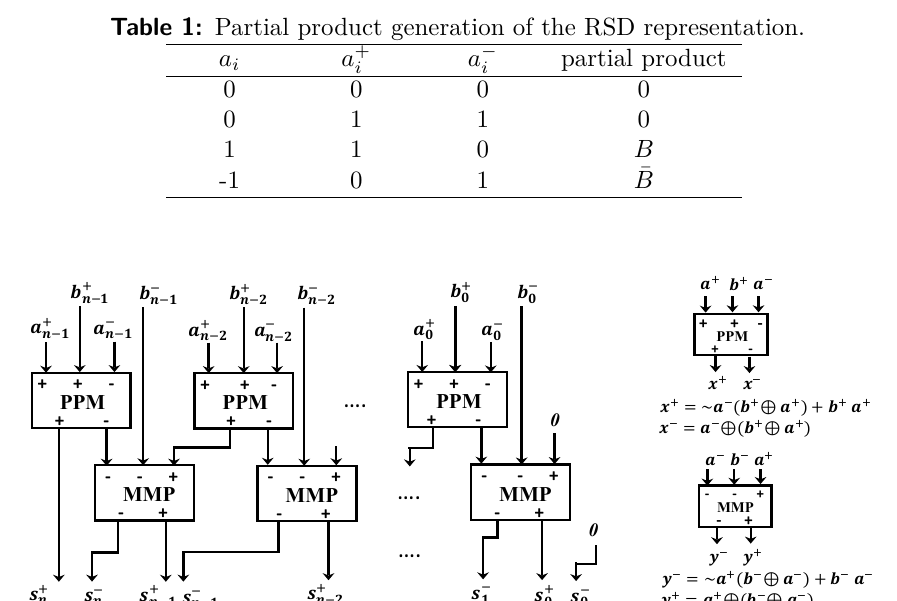
Table 1: Partial product generation of the RSD representation.